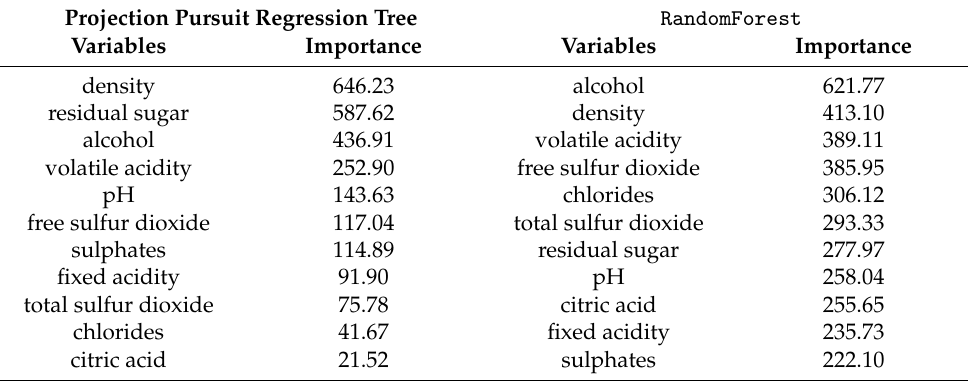
Table 5. Importance measures of the white wine data.